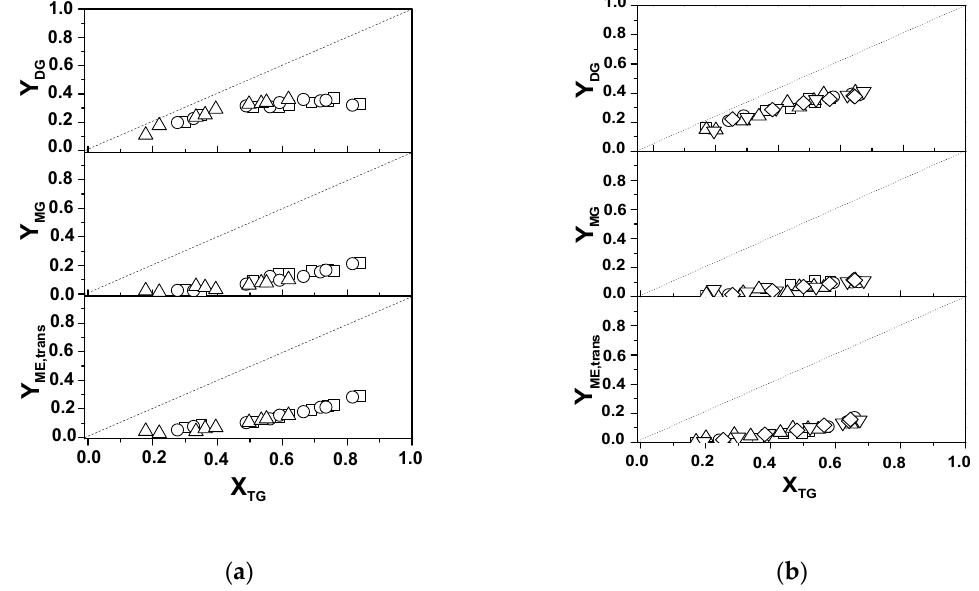
Figure6. Evolutionwiththetriglyceridesconversionoftheyieldsofdiglycerides(Y DG ), monoglycerides (Y MG ), and methyl esters produced by transesterification (Y ME,trans. ) for: ( a ) unsupported Mo (300) (squares), Mo (500) (circles), and Mo (700) (triangles) catalysts; ( b ) supported s-Mo (6) (squares); s-Mo (8) (circles); s-Mo (10) (triangles); s-Mo (13) (inverted triangles); s-Mo (16) (rhombus) catalysts. Reaction conditions: 100 ◦ C, 30 atm, methanol:feedstock molar ratio of 12:1, 2 wt.% catalyst referred to